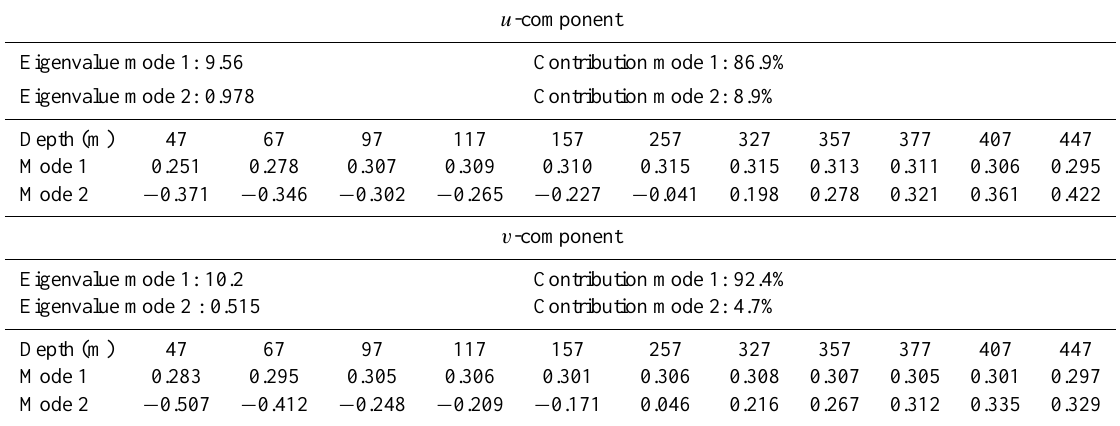
Table 4. EOF eigenvectors and total variance explained for the u and v current components during the second phase (06 Sep 2000 – 01 Mar 2001; J.D. 250 – J.D.